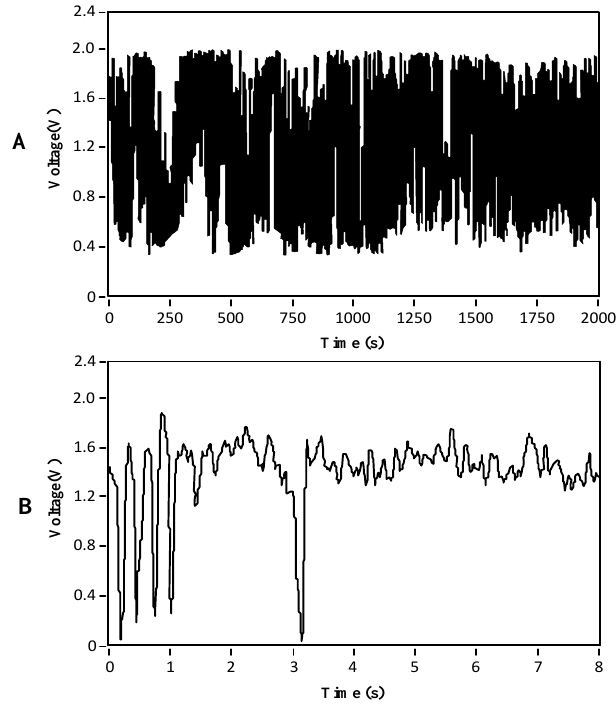
Figure 11. Field test data curve of the bubbles during a certain time period. ( A ) 2000 s of field test data; ( B ) part data for further analysis.